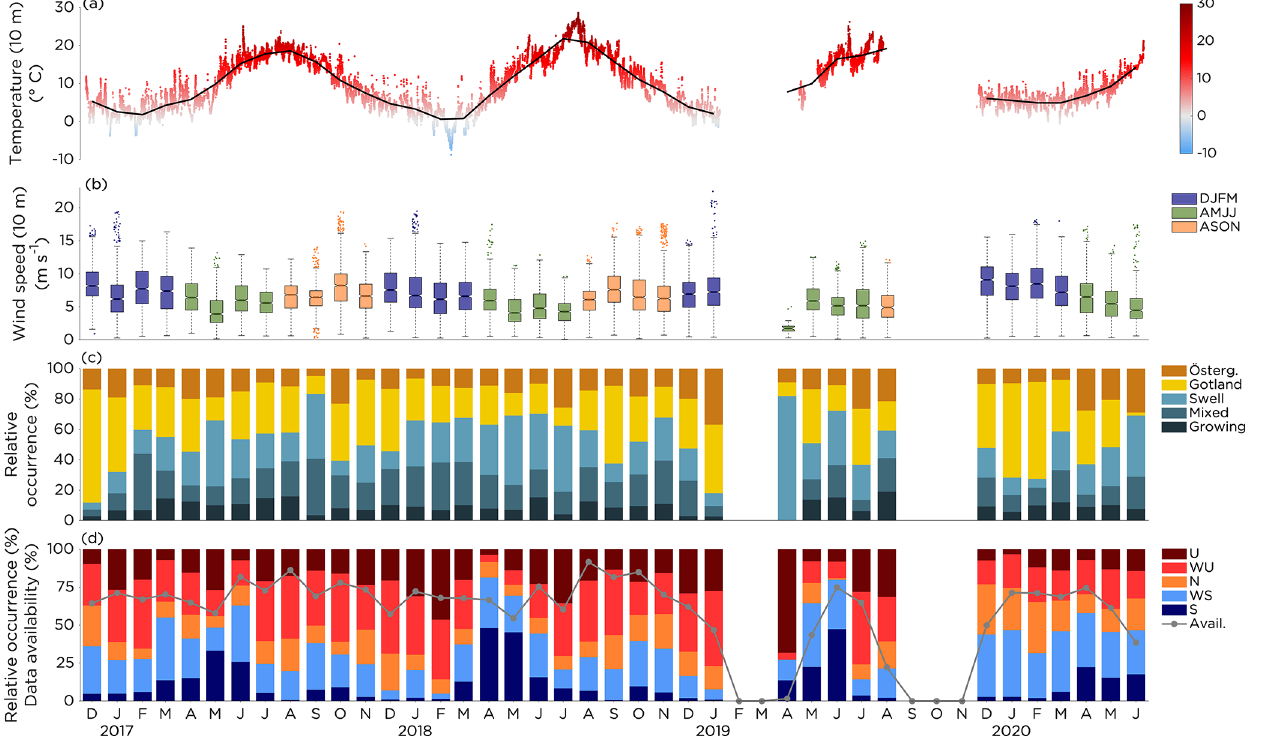
Figure 2. Overview of the (a) temperature (10m), (b) wind speed (10m), (c) wind direction (10m) and wave age, and (d) stability of the atmospheric surface layer (see Sect. 3.6) during the period of measurements, 8 December 2016 to 24 June 2020. In (a) all 30min average temperatures are plotted together with the monthly mean (black line). In (b) the boxes are colored based on season (see Sect. 4.2). The line in the boxes mark the median value, and the bottom and top edges mark the 25th and 75th percentiles, respectively. The dots indicate the outliers, and the whiskers indicate the most extreme wind speeds not considered outliers. The notches mark the 95% confidence interval of the median. In (c) the cases when the wind was directed from the open-sea sector were divided into growing sea, mixed sea and swell based on the wave age as described in Sect. 3.4. In (d) , the monthly data availability is plotted (grey line) in addition to the atmospheric